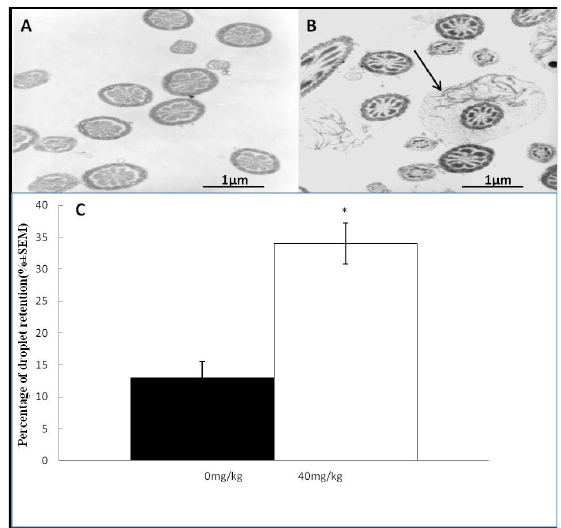
Figure 3. Electron microscopic analysis of the effect of dutasteride treatment on sperm morphology. ( A ) In the control group, there was no mid-piece sperm surrounded by cytoplasmic droplets; ( B ) After dutasteride treatment, there were some mid-piece sperms surrounded by cytoplasmic droplets (black arrows); ( C ) Comparison of the percentage of sperms droplet retention between the control and dutasteride groups. * p < 0.05 versus the control group.